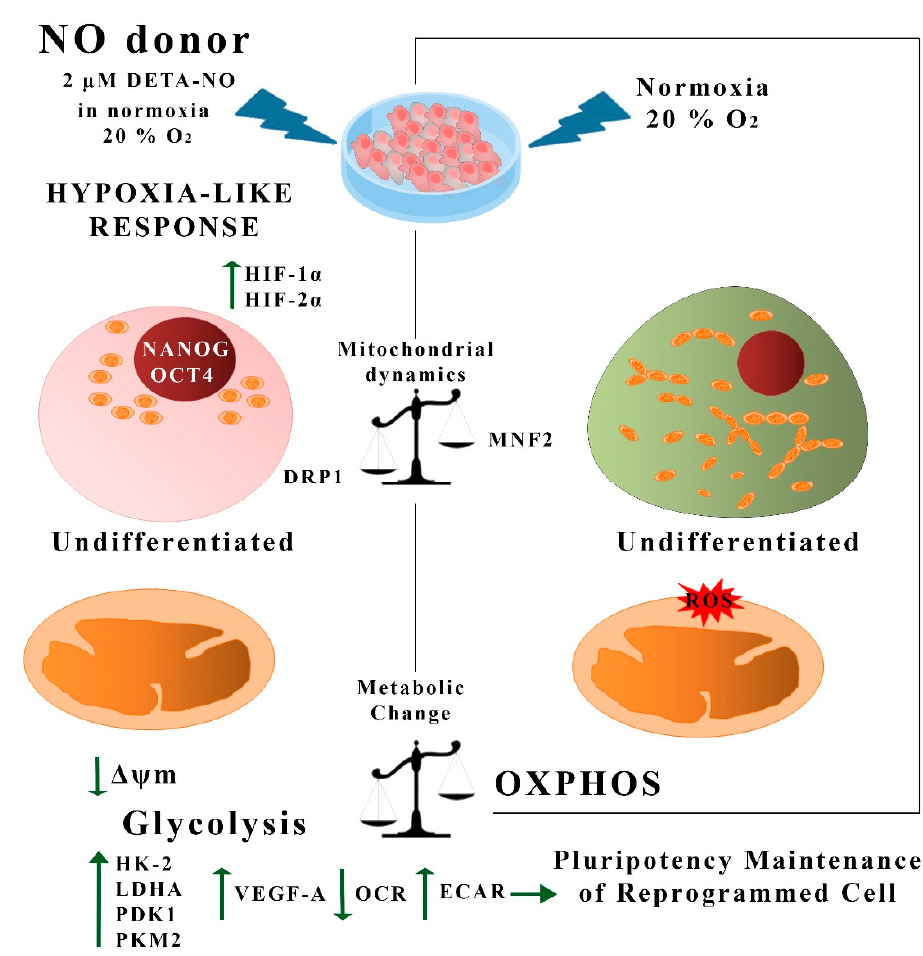
Figure 9. Summary of hypoxia-like actions of NO in human PS cells. In this study, we show that treatment with low doses of DETA-NO in normoxia induces a response similar to hypoxia in PSCs. Thus, exposure to 2 µM DETA-NO led to the accumulation of HIF-1 α and HIF-2 α proteins, enhanced expression of pluripotency genes NANOG and OCT-4, and a shift towards the expression of genes favoring anaerobic metabolism and tissue reoxygenation. Mitochondrial function and dynamics were also affected, with a decrease in O 2 consumption and Δψ m, an increase in DRP1 expression, and a decrease in MFN2. These actions are not dependent on changes in mROS levels. All in all, the results provided here indicate that NO induces a hypoxia-like response, regulating mitochondrial functionality and metabolic parameters in human PSCs, thus favoring pluripotency. NO (nitric oxide); ROS (reactive oxygen species); OCR (O 2 consumption rate); ECAR (extra- cellular acidification rate), OXPHOS (oxidative